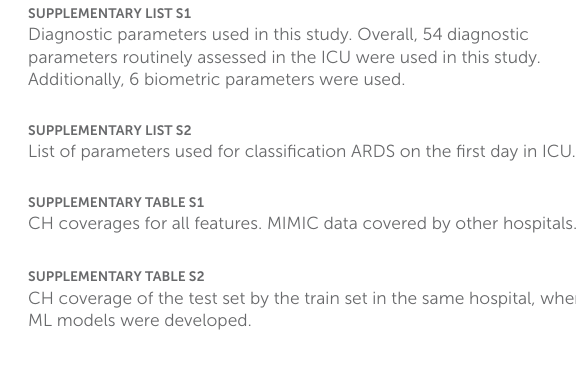
SUPPLEMENTARYTABLES1 CH coverages for all features. MIMIC data covered by other